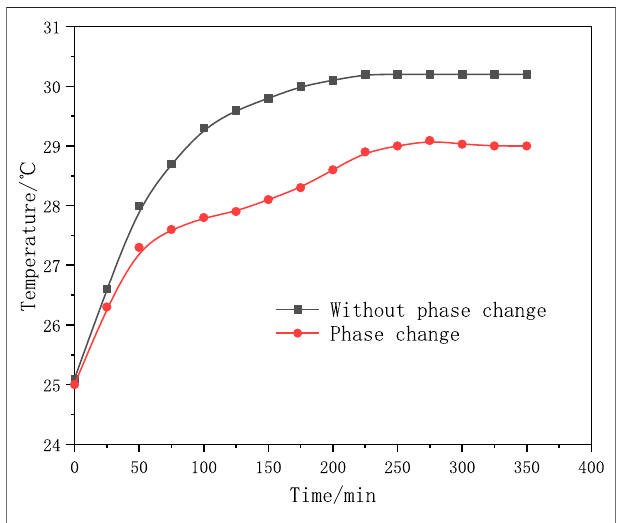
FIGURE 15 | Temperature change curves of internal north wall of the building model with and without phase change.